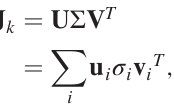
, Y ) of the contour of the two i i